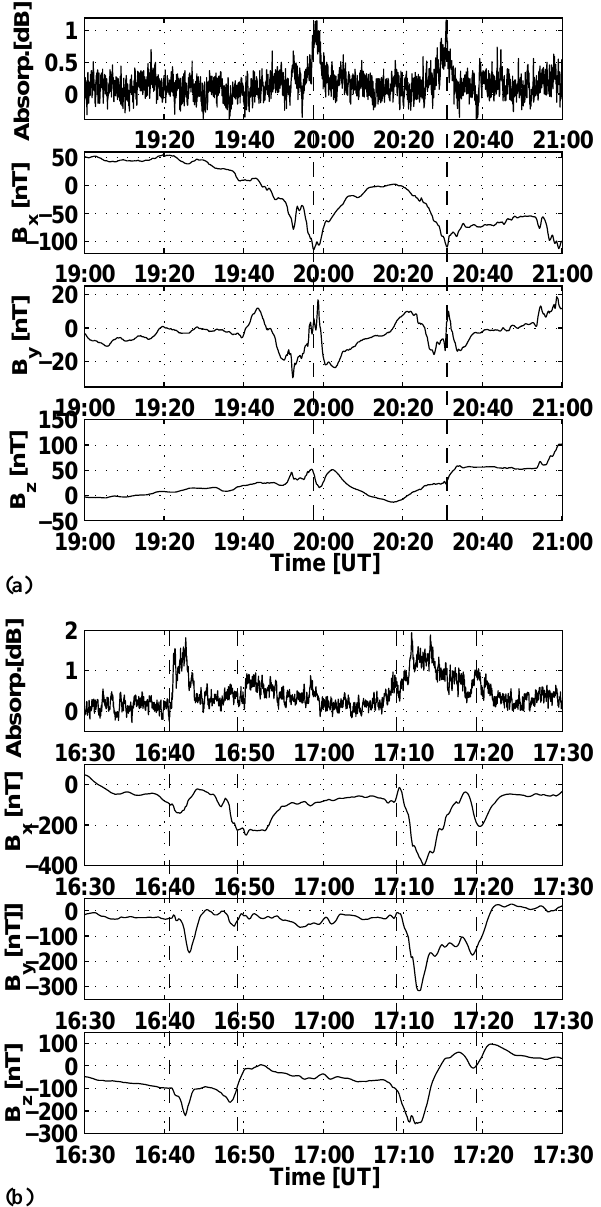
Fig. 1. The four panels in (a) and (b) above show (from the top) the wide-beam absorption data (IRIS) and the ground magnetic com- ponents (IMAGE) at Kilpisj¨arvi, Finland on 5 October 1999 from 19:00 to 21:00 UT and on 25 October 1999 from 16:30 to 17:30 UT. There are two different activations observed on 5 October 1999 at 19:57 and 20:30 UT, both in absorption and ground magnetic data. Note the clear signature of Pi2 pulsations in the magnetic Y- component from 19:55 to 20:00 UT! On 25 October 1999 there are four different activations observed at 16:41, 16:49, 17:09 and 17:19